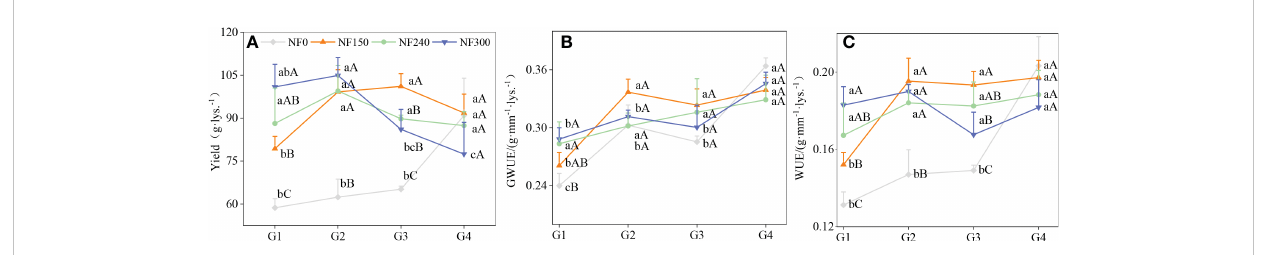
FIGURE 6 Winter wheat yield, WUE and GWUE. Different lowercase letters indicate signi fi cant differences were among different WTDs under the same N application rate, P < 0.05. Capital letters indicate signi fi cant differences among different N application rates under the same WTD, P <